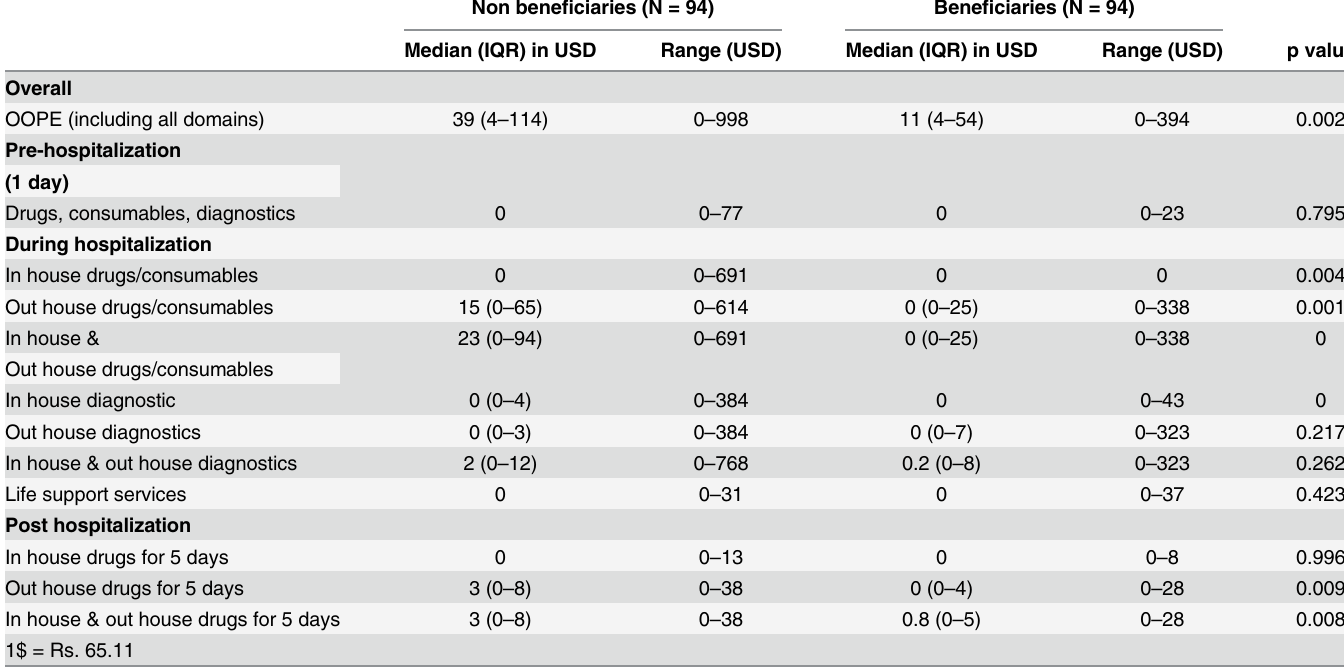
Table 4. Median out of pocket expenditure (OOPE) among non-beneficiaries and beneficiaries, Solan, Himachal Pradesh, India, 2013.